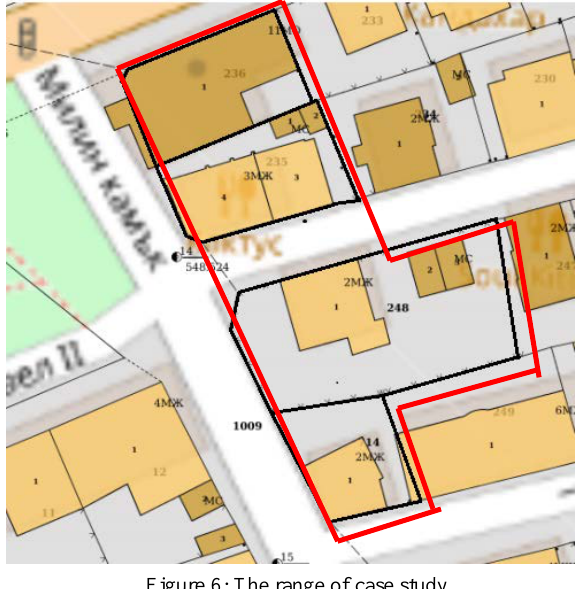
Figure 6: The range of case